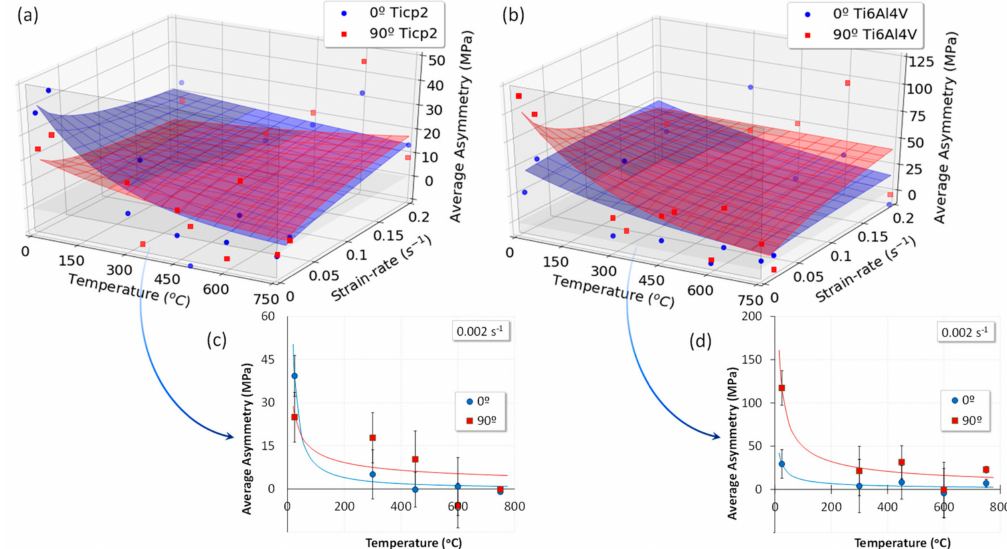
Figure 14. Average asymmetry as a function of the temperature and strain-rate. ( a ) Ticp2; ( b ) Ti6Al4V; ( c , d ) Evolution of the average asymmetry for a strain rate of 0.002 s − 1